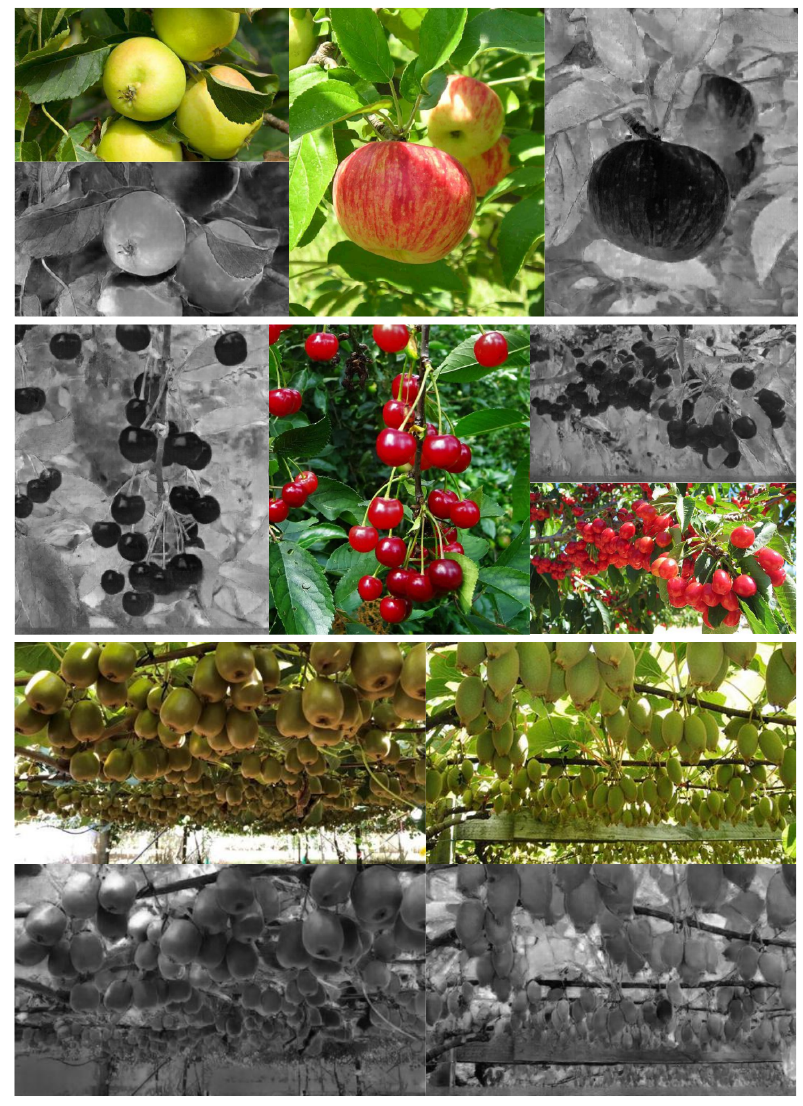
Figure 16. Synthetic NIR generation other than capsicum dataset. Each row shows the results for apple, cherry and kiwi, respectively. Apple detection performance improved 0.005 mAP synthetic NIR. Whereas cherry and kiwi’s performance decreased by 0.03 and 0.09 mAP